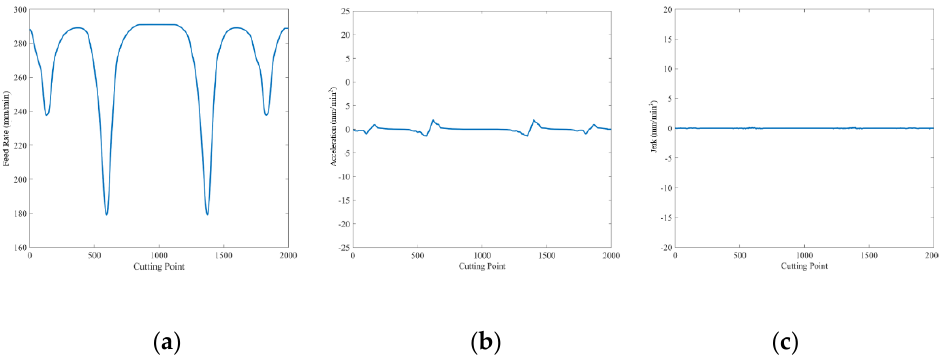
Figure 17. Cutting ∞ shape using our method: ( a ) feed rate, ( b ) acceleration, and ( c ) jerk. Table 7. Tracking error and processing time of ∞ shape.